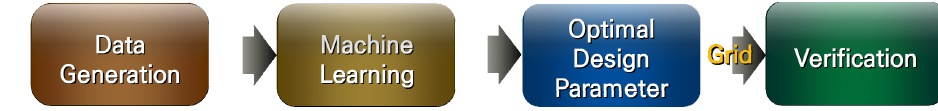
Figure 3. The block diagram of the proposed